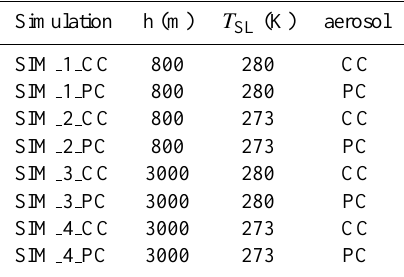
Table 2. Parameter specifications for the idealized set of simula- tions. All simulations are conducted with a sea-level pressure of p sl = 1000hPa, a dry Brunt-V¨ais¨al¨a frequency of N d = 0 . 011 s − 1 and a mountain half-width of a 0 = 20km. Aerosol conditions are prescribed according to a clean case (CC) or a polluted case (PC).